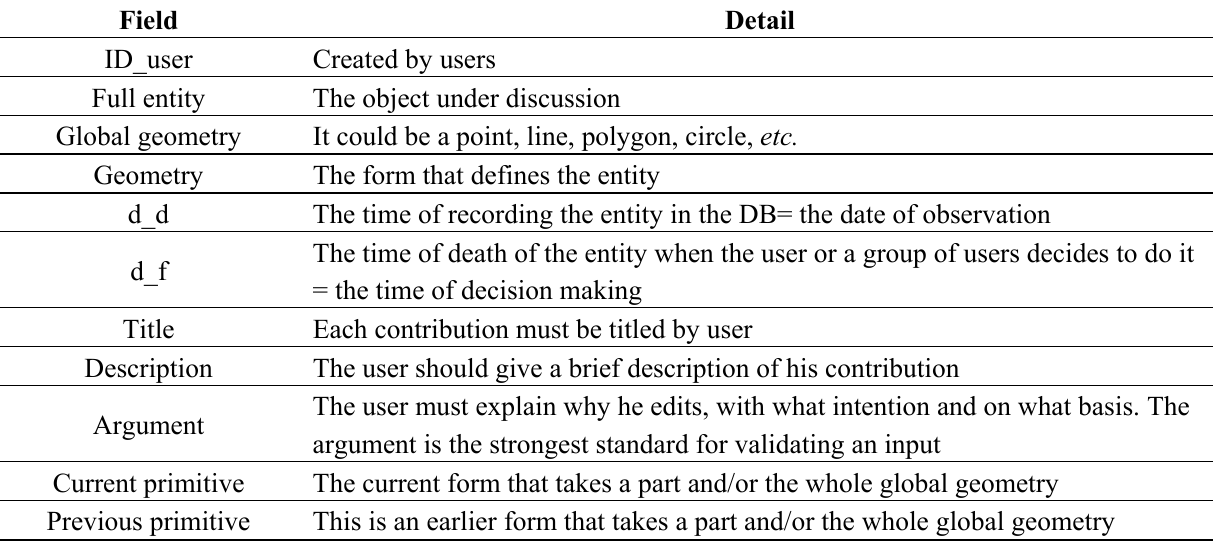
Table 2. Structure of WikiGIS’s